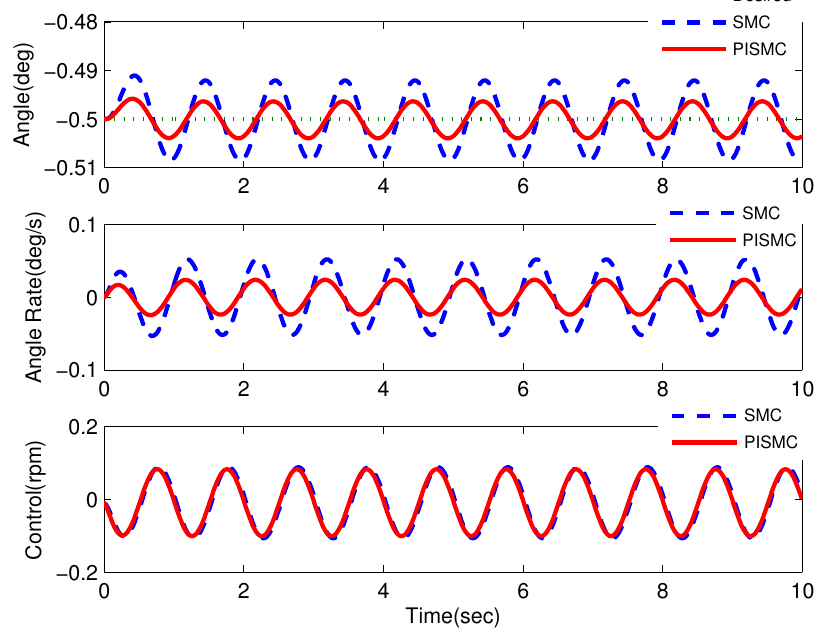
Figure 12. Balance response to PISMC with disturbances of sin ( 2 π t ) : ( top ) angular response; ( middle ) response of angular rate; ( bottom ) applied control